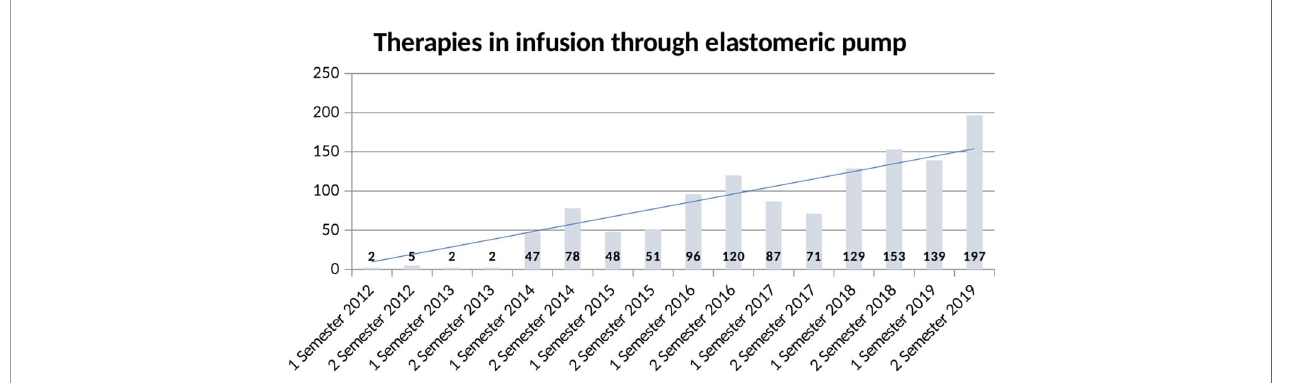
FIGURE 3 | Volume of therapies administered in infusion through